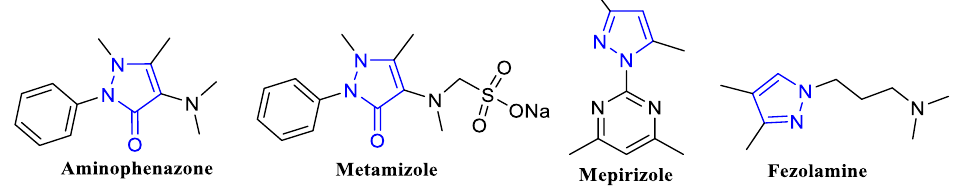
Figure 2. Pharmaceutical preparations containing a pyrazole